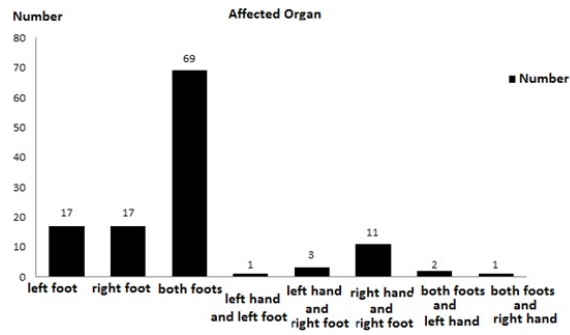
Figure 2. Number of Affected Organs by Acute Flaccid